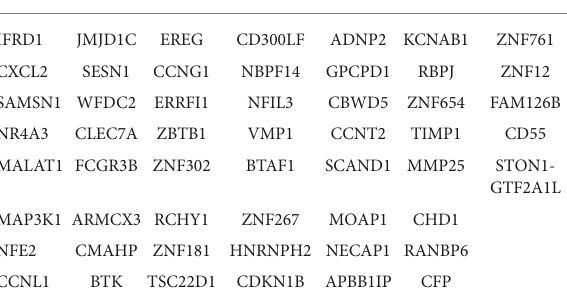
TABLE 1 Common genes of asthma and COVID-19 ( n =